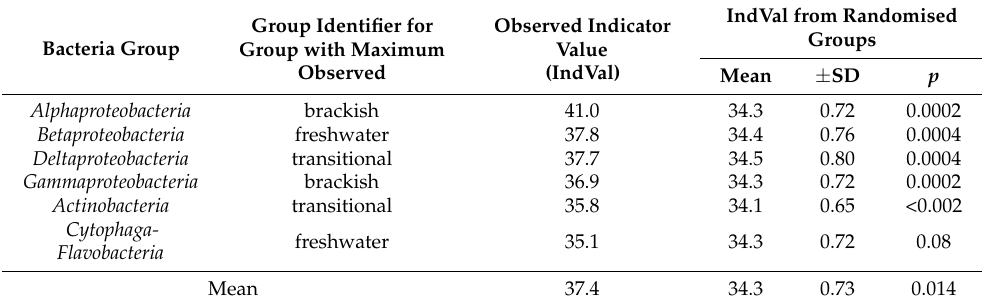
Table 6. Indicator Species Analysis (ISA) of bacteria groups for habitat types of coastal lakes. Group Identifier for Bacteria Group Group with